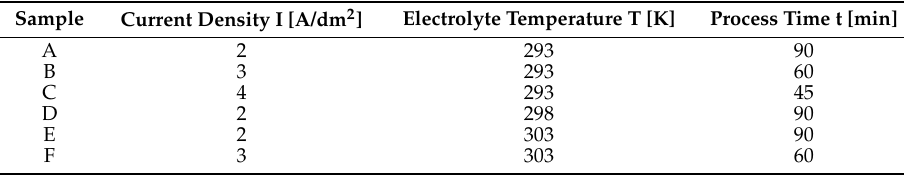
Table 2. Initial conditions of